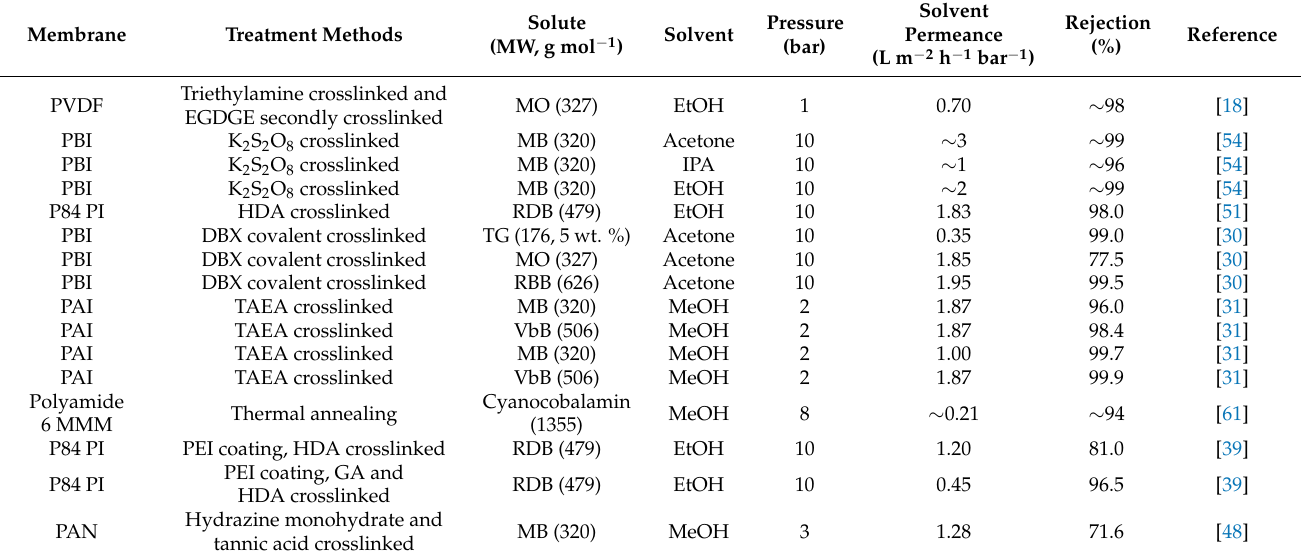
Table 1. OSN performances of ISA HF OSN